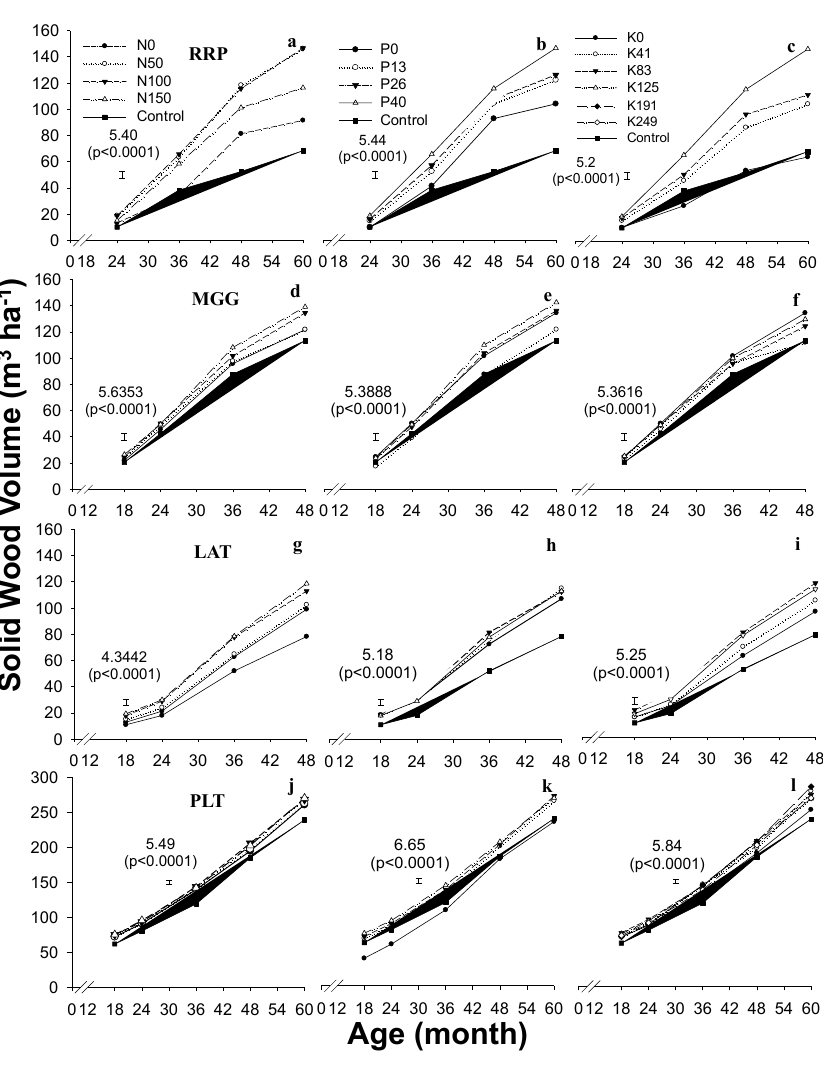
Figure 4. Solid wood volume with bark (SV) according to the applied rates of N ( a , d , g , j ), P ( b,e,h,k ) and K ( c,f,i,l ) in RRP ( a – c ), MGG ( d – f ), LAT ( g – i ) and PLT ( j – l ). Bars indicate the least significant difference by the LSD test ( p < 0.05). Forests 2016 , 7 , 0000